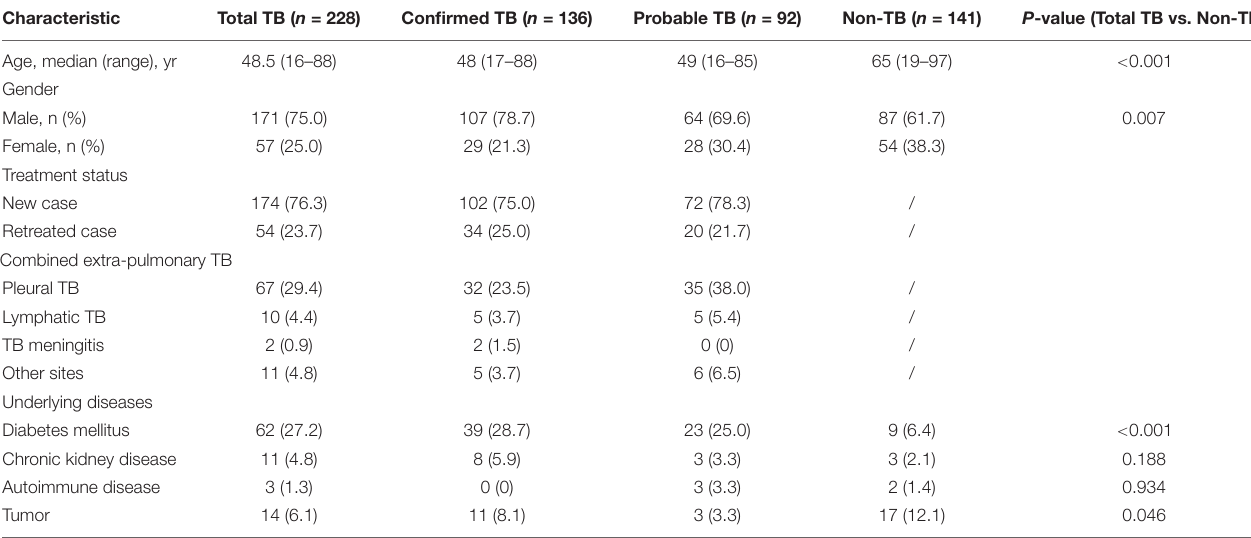
TABLE 1 | Demographic and clinical characteristics of the study population.